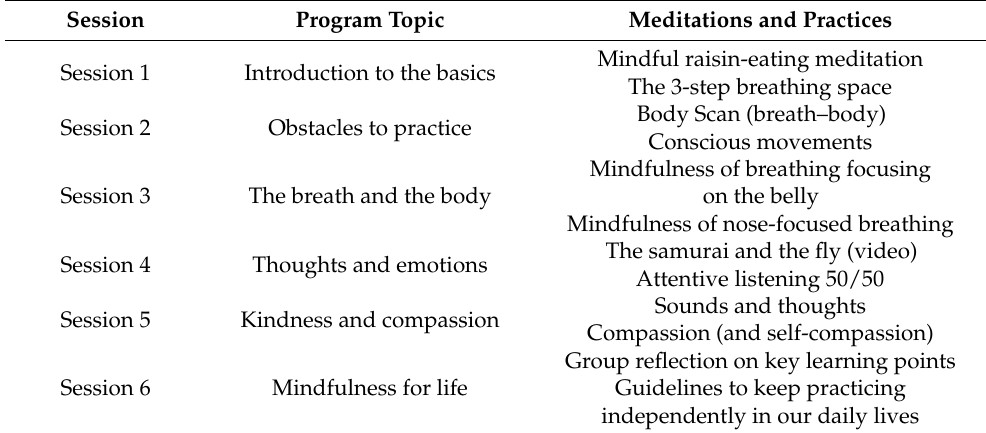
Table 2. Sessions of the mindfulness- and compassion-based program for university